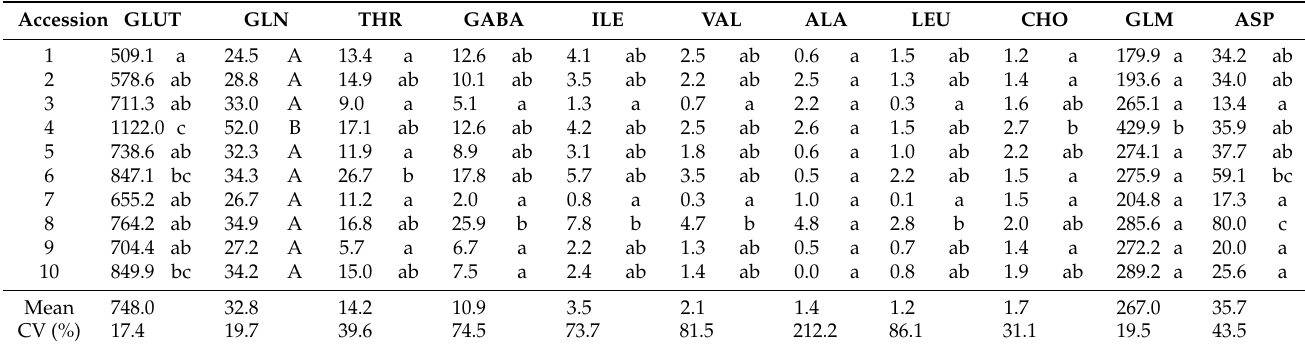
Table 4. Means (fruits quintuplicate for each accession) of amino acids and related compounds determined by NMR and expressed in mg 100 g − 1